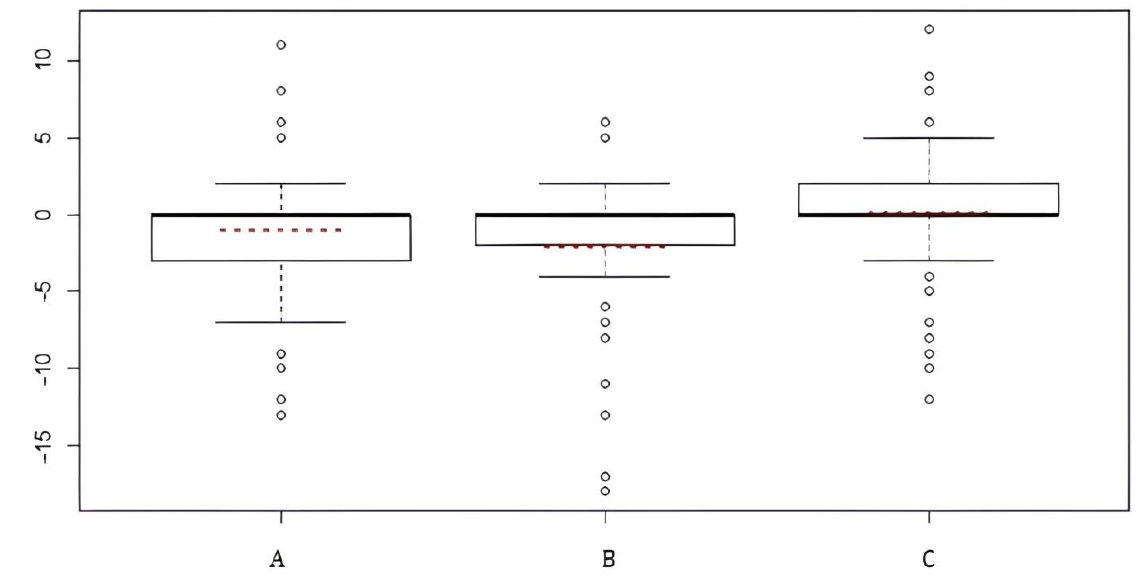
Figure 5. Comparison between preoperative ( a ) and postoperative EAT data ( b ) based on moni- toring techniques. A = visual technique; B = intermittent nerve monitoring; C = continuous nerve monitoring.